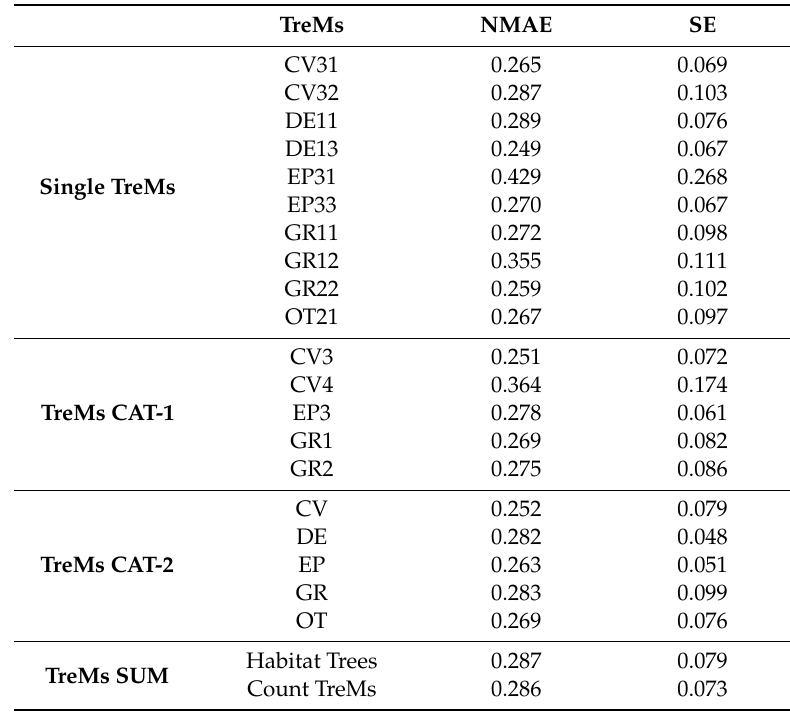
Table 3. Random forest predictive performance. For each microhabitat variable, the NMAE (Normalized Mean Absolute Error) and the standard error (SE) are